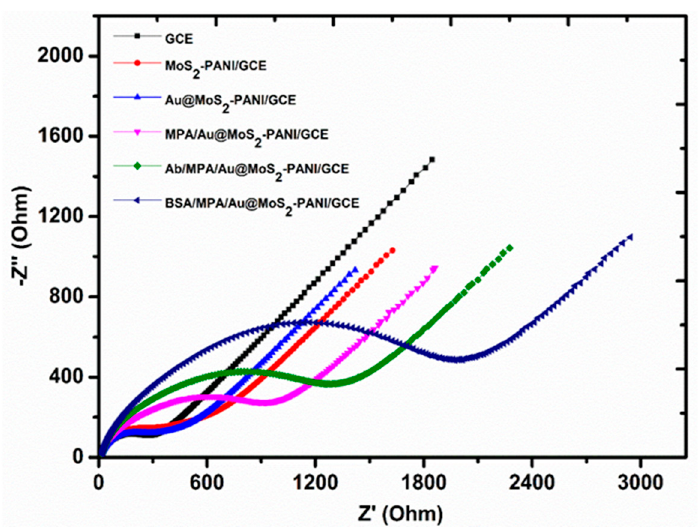
Figure 6. Impedance spectra of the immunosensor in 5 mM of [Fe(CN) 6 ] 3 − /4 − , 0.1 M of KCl, and 100 mM PBS buffer (pH = 7.4).